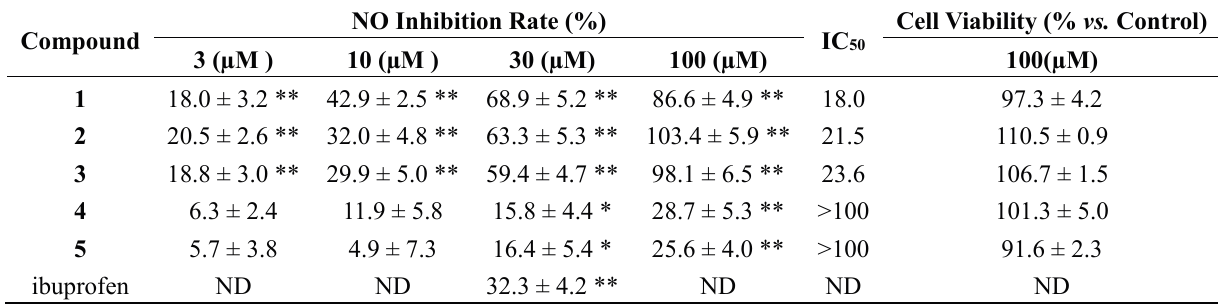
The results were expressed as the mean ± SD. of three independent experiments. * p < 0.05, ** p < 0.01, vs